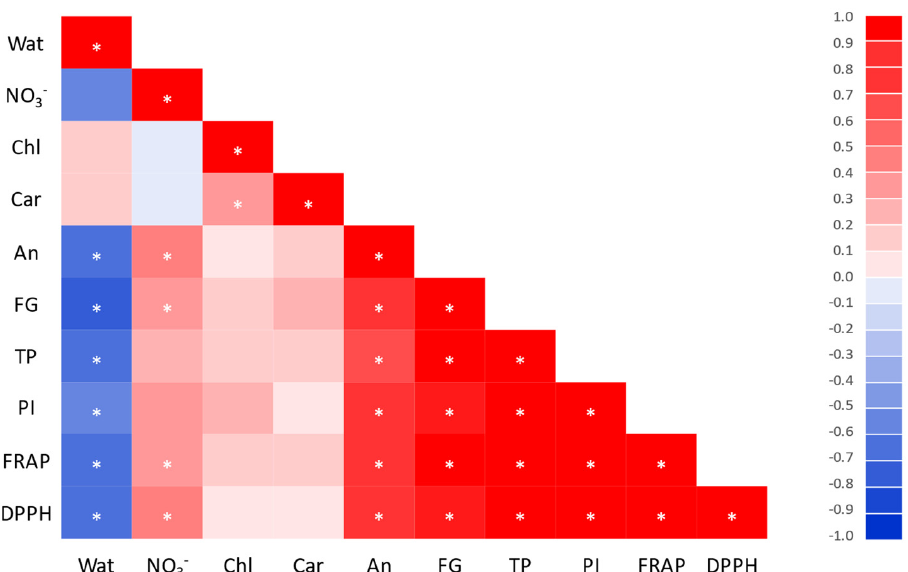
Figure 3. Pearson’s coefficients for quality parameters of the fresh leaf tissues of Reichardia picroides plants grown in floating system with different NaCl concentrations in the nutrient solution (1.7, control; 25; 50; 100 mM) and sampled four and six weeks after transplanting. Four replicates were collected for each treatment and sampling time. Wat: water content; NO 3 − : nitrates; Chl: total chlorophylls; Car: carotenoids; An: anthocyanins; FG: flavonol glycosides; TP: total phenols; PI: phenol index; FRAP: ferric reducing antioxidant power; DPPH: 2,2-diphenyl-1-picrylhydrazyl radical scavenging activity. * denotes statistical significance at p < 0.05.